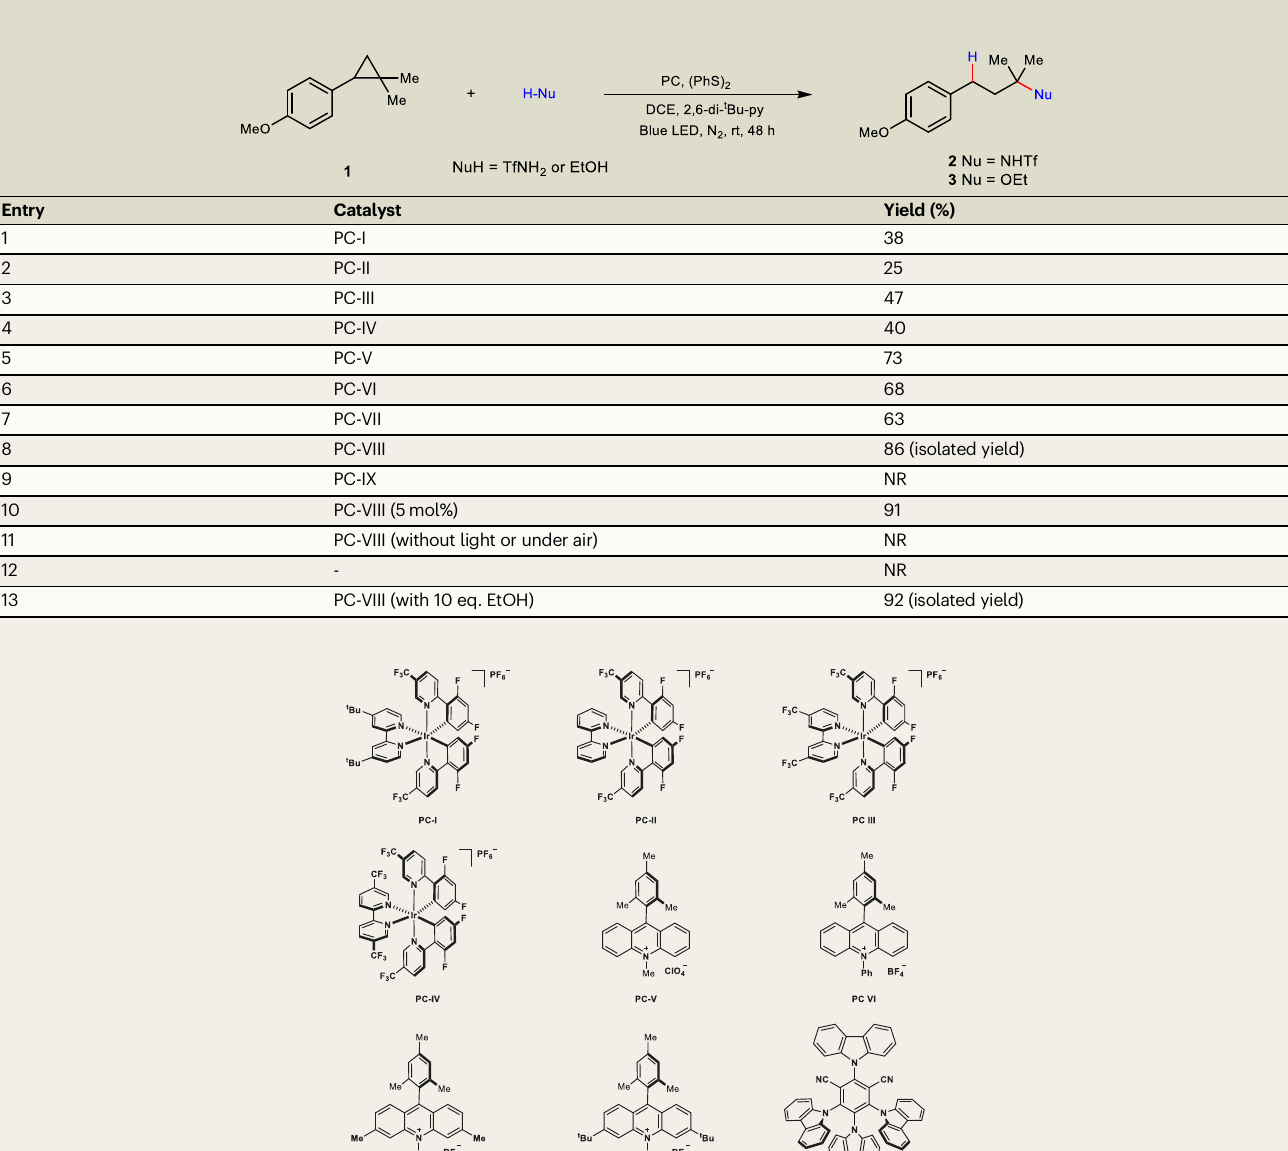
Table 1 | Reaction conditions